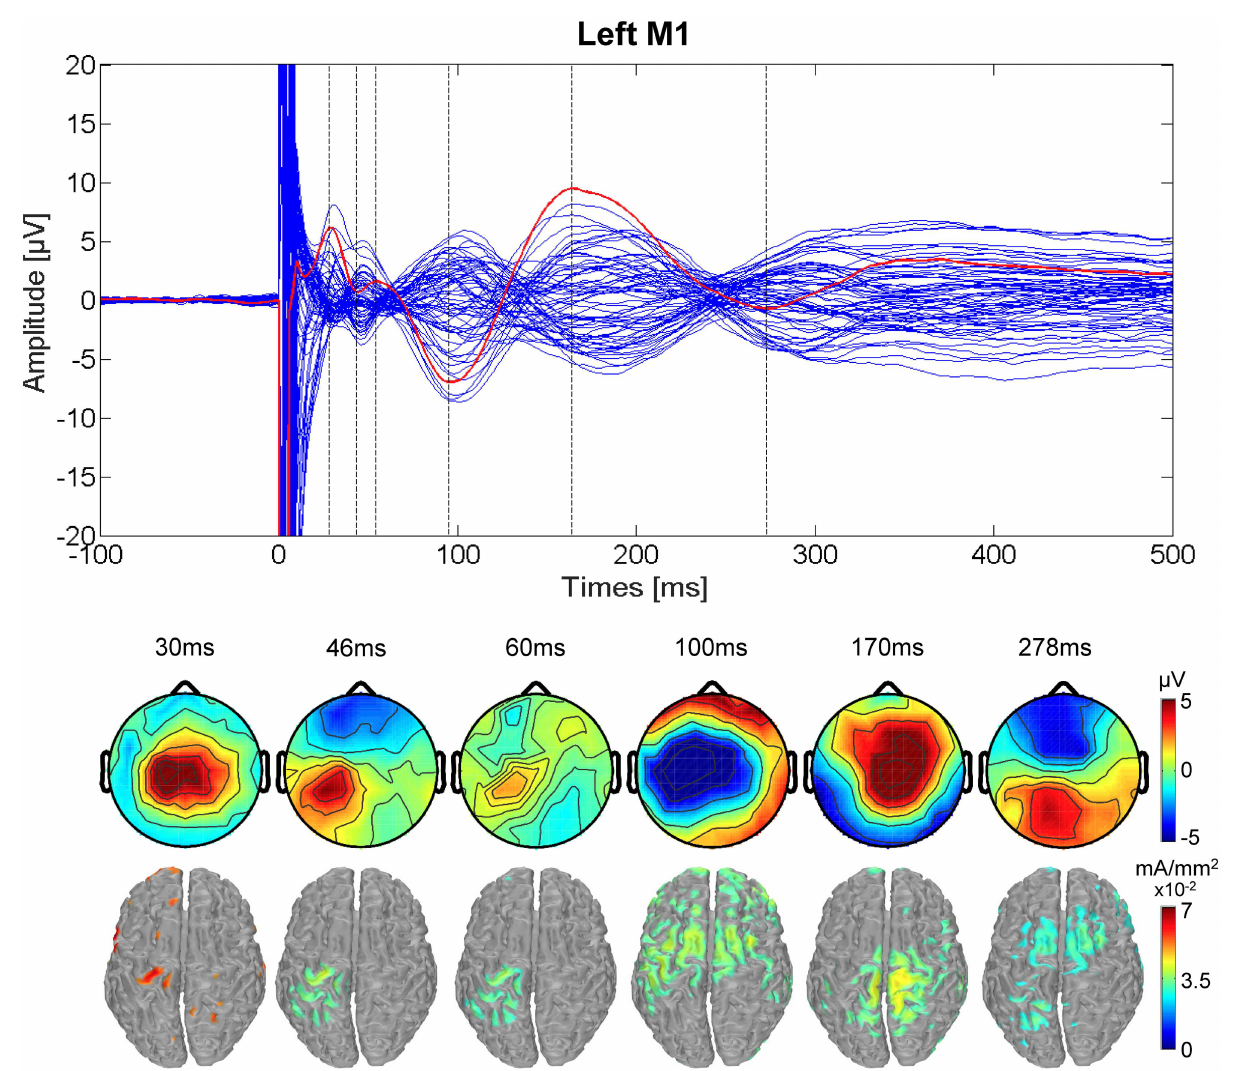
Fig 1. TEPs for left M1 stimulation. (Upper) Butterfly plot of the averageTMS-evoked activity from all electrodes (averageof all 17 participants). Red line indicatesCz electrode.Timing of the peaks is indicatedby vertical dashedlines. (Lower) Voltage distributions (top) and Minimum Norm estimates (bottom) of the TMS-evoked activity for each peak in the Cz waveform. The cortical current density estimates have been thresholded to show the maximal activity at each peak.